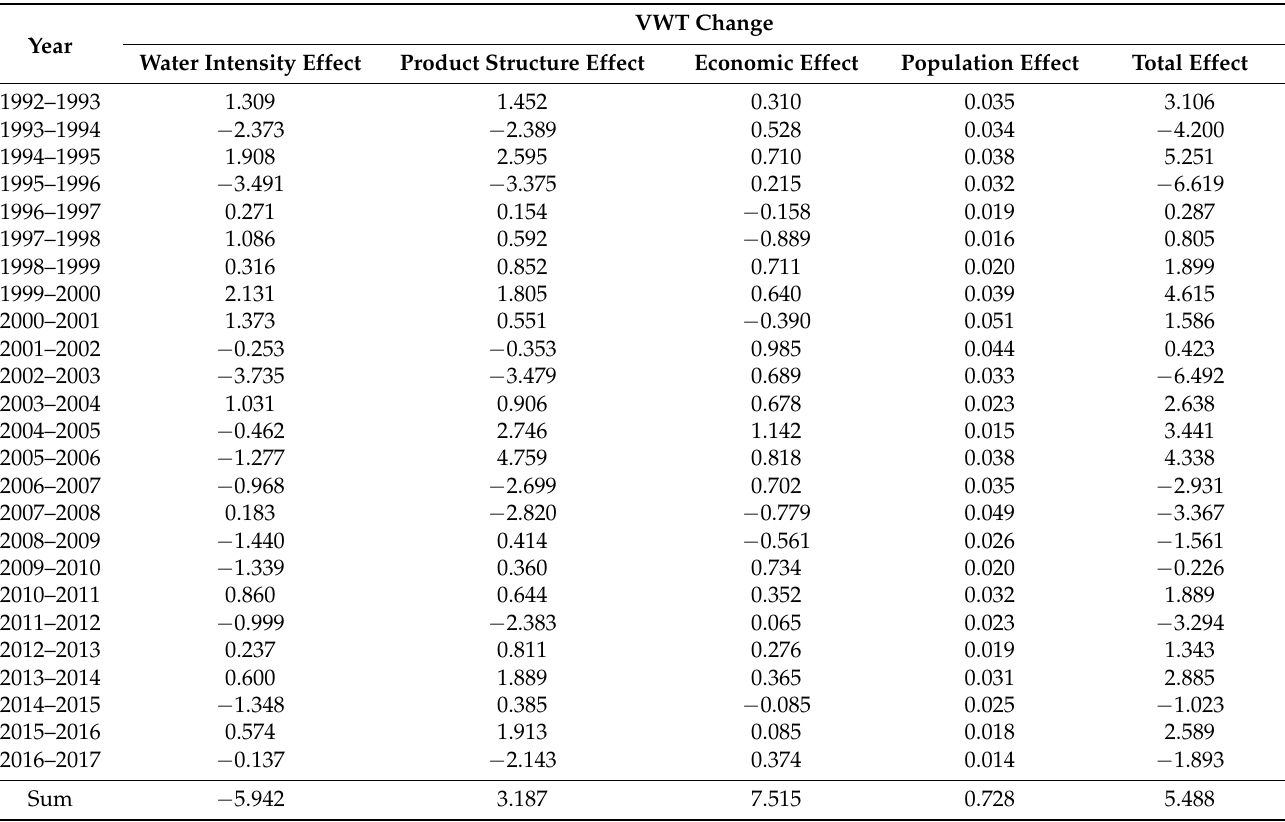
Table A2. The logarithmic mean divisia index (LMDI) analysis of buckwheat virtual water trade (VWT) change in South Korea (million m 3